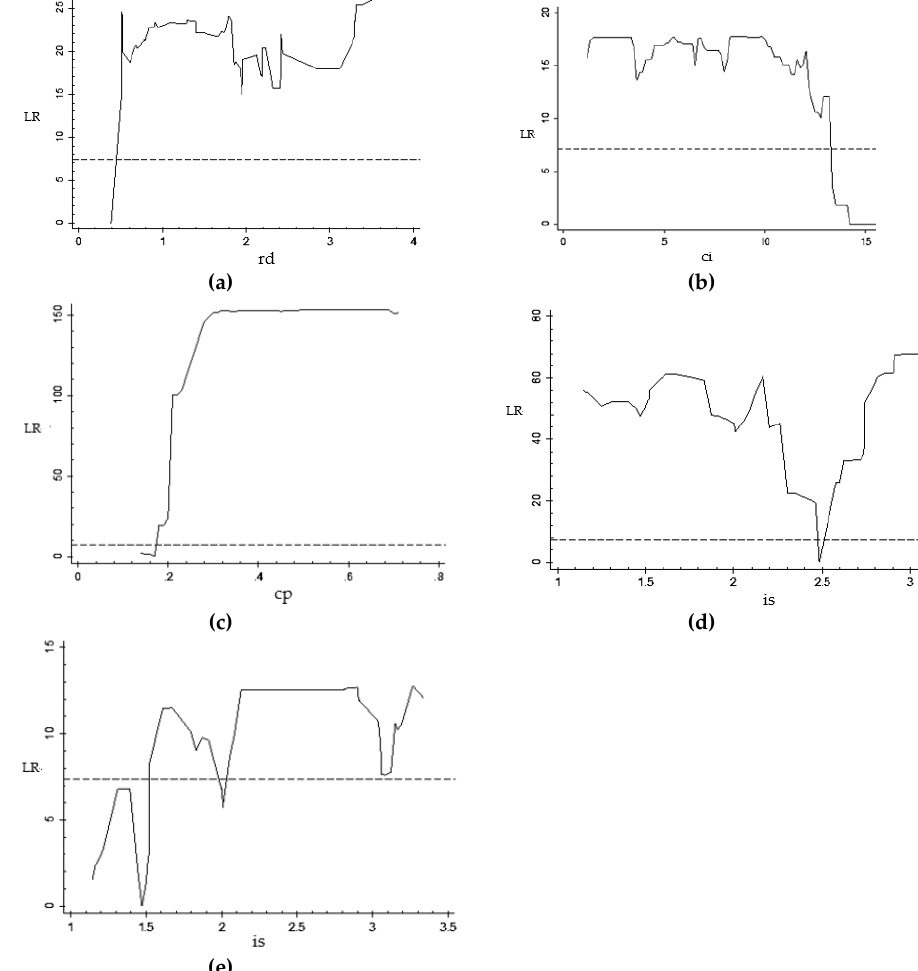
Figure 2. Likelihood ratio value and threshold parameter diagram of loan size and carbon emissions. ( a ) rd-single-threshold model; ( b ) ci-single-threshold model; ( c ) cp-single-threshold model; ( d ) is-single-threshold model; ( e ) is-double-threshold model.